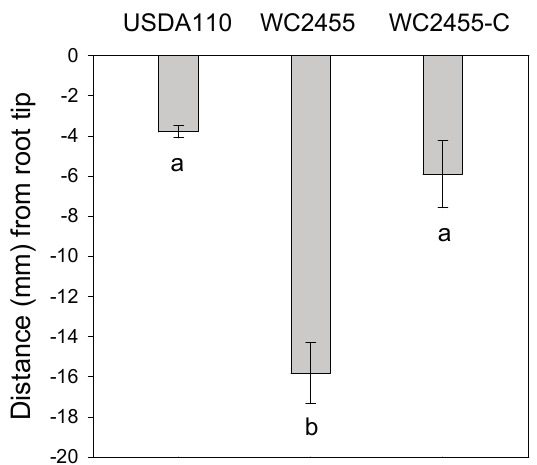
Figure 4. The effect of ace A gene on nodulation of B. japonicum . The average distance (mm) of nodules form root tip (RT). Values are means ± standard errors of the means from nine replications. The different letters below the bars indicate that the data are significantly different from each other ( p < 0.05, JMP ® 8 software (SAS Institute Inc., Cary, NC,